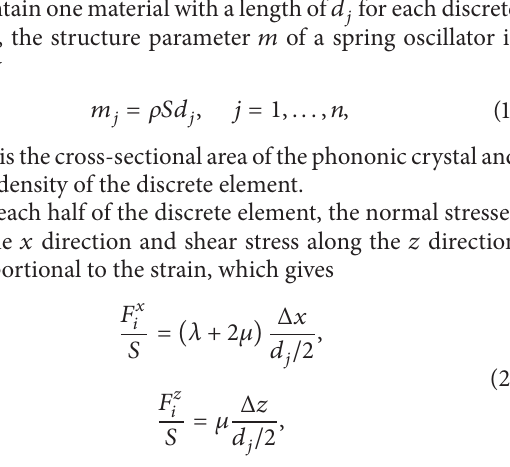
Table 2. For a comparison of band structure, the parameters of aluminum and epoxy are also listed.